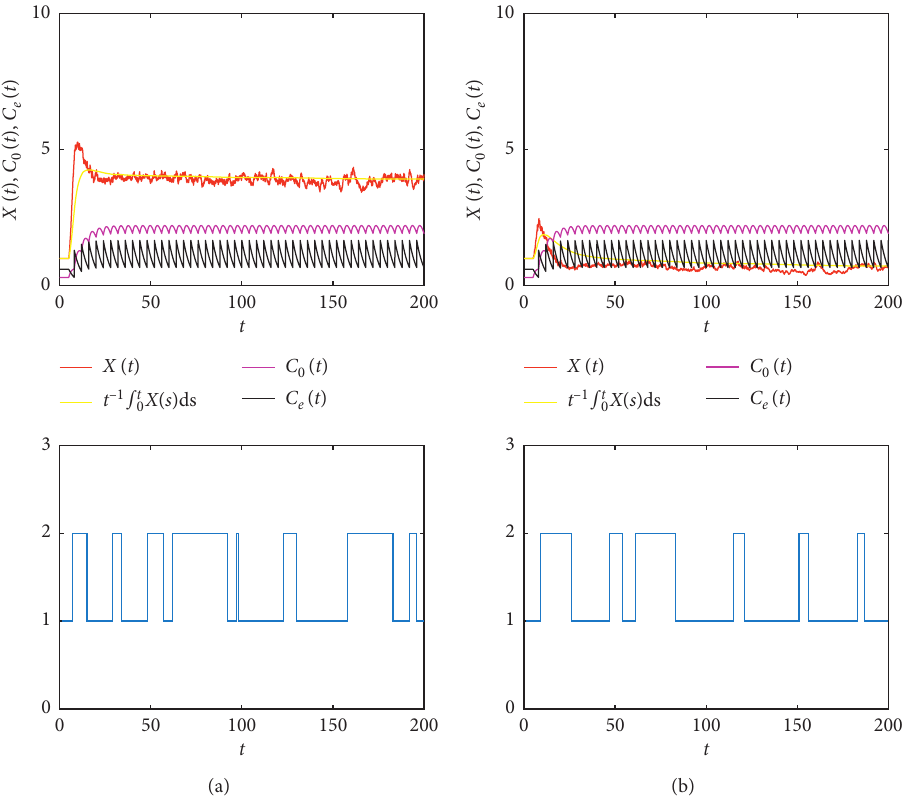
Figure 4: Effect of telegraph